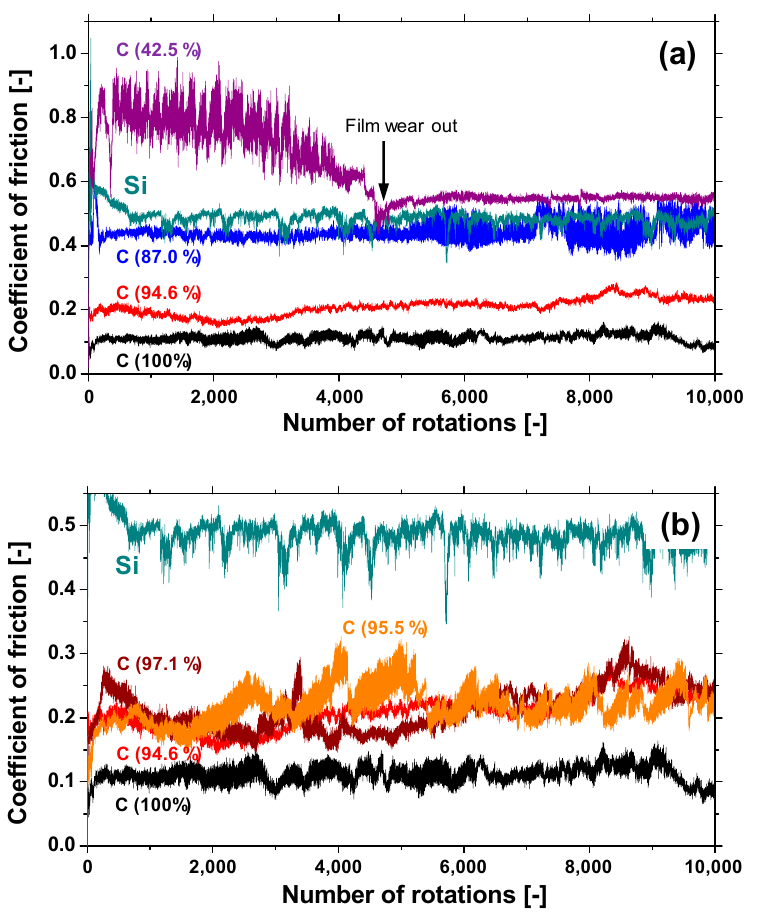
Figure 10. ( a ) The evolution of the friction coefficient of samples with different carbon content. ( b ) The evolution of the friction coefficient of samples with a carbon content >90%.